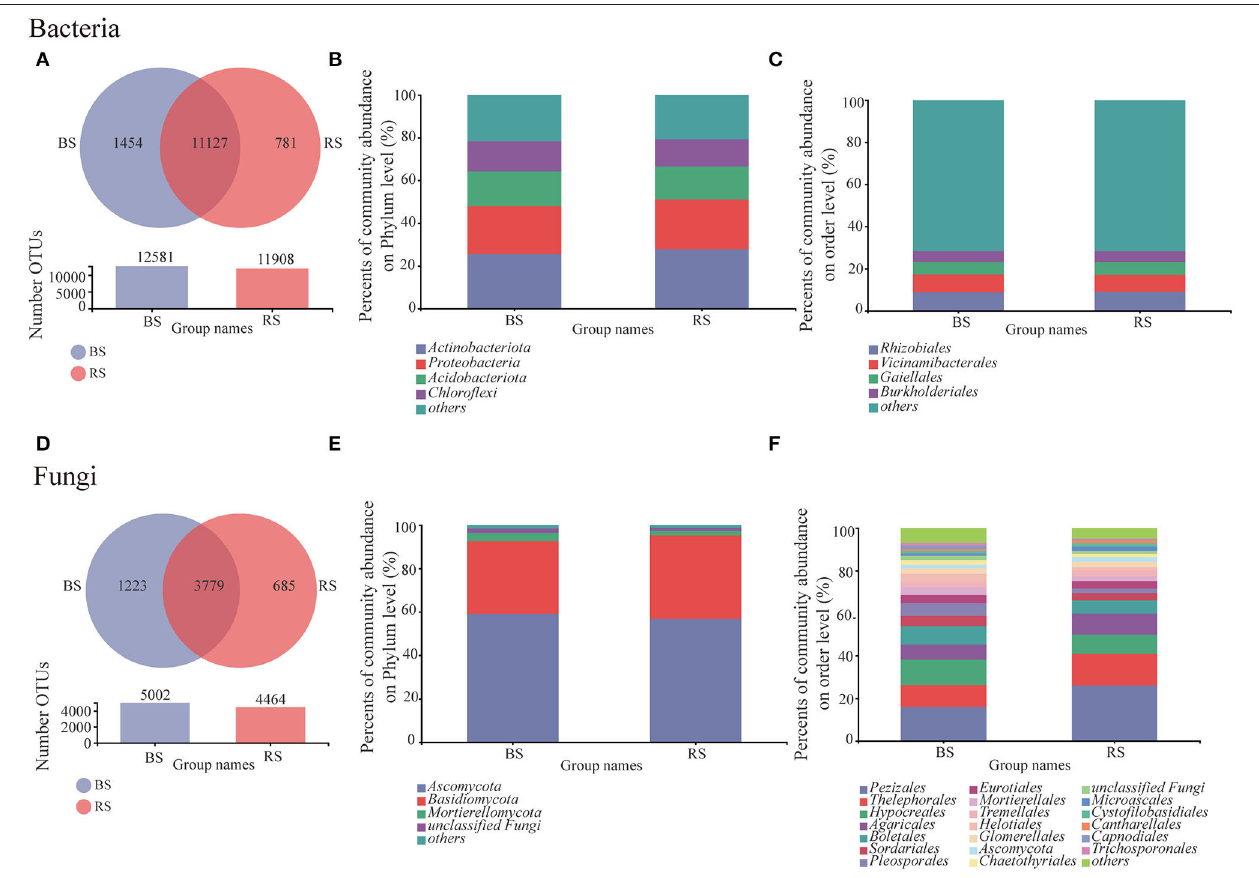
FIGURE 3 | Bacterial and fungal community compositions in the rhizosphere and bulk soils. (A,D) Venn diagram for the OTU numbers. (B,E) and (C,F) relative abundances of bacteria/fungi at phylum and order levels, respectively. BS and RS, bulk soil and rhizosphere soil,